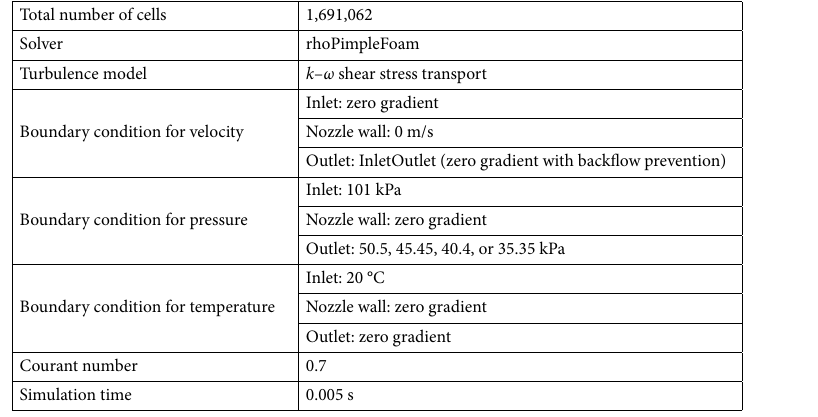
Table 1. Conditions of the numerical